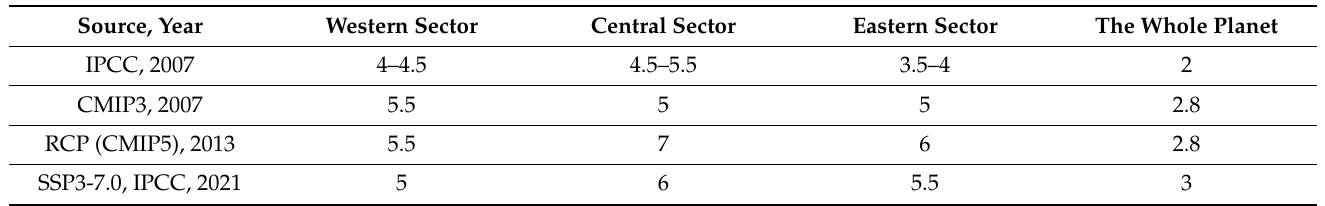
Table 1. The estimates of the increase in average annual air temperature in the AZRF during 21st century ( ◦